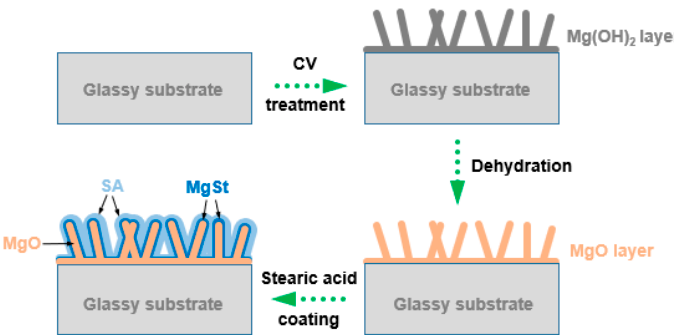
Figure 1. Schematic illustration showing the synthesis procedure of the stearic acid coated MgO hydrophobic film on the Mg 66 Zn 30 Yb 4 glassy ribbon (GR).